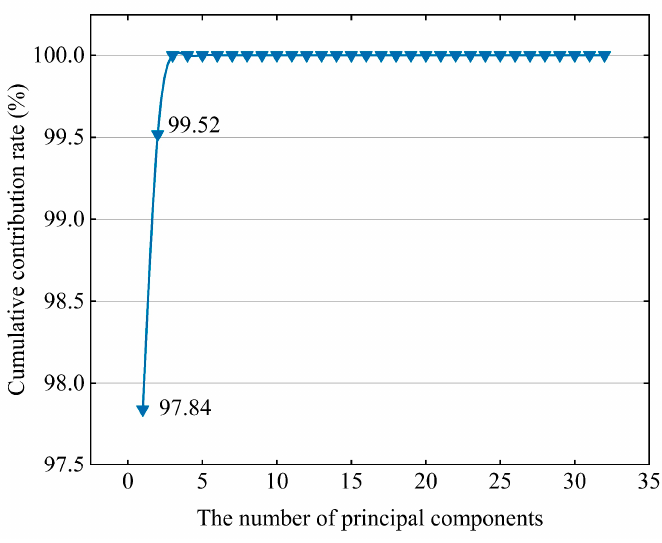
Figure 8. Results of the cumulative contribution rate. The optimized sample data were normalized after optimization. Since damage data are more difficult to obtain in engineering, this study built a training set with healthy data. Four hundred healthy samples were used as training sets. The test sample contained 100 healthy and 100 damaged samples, in which the healthy samples were positive samples and the damaged ones were negative samples. The conventional SVDD method calculates the center and radius of the sphere in the positive state. The penalty parameter C is initially set to 20. The Gaussian kernel function is selected as the kernel function, and the kernel parameters are initially set to